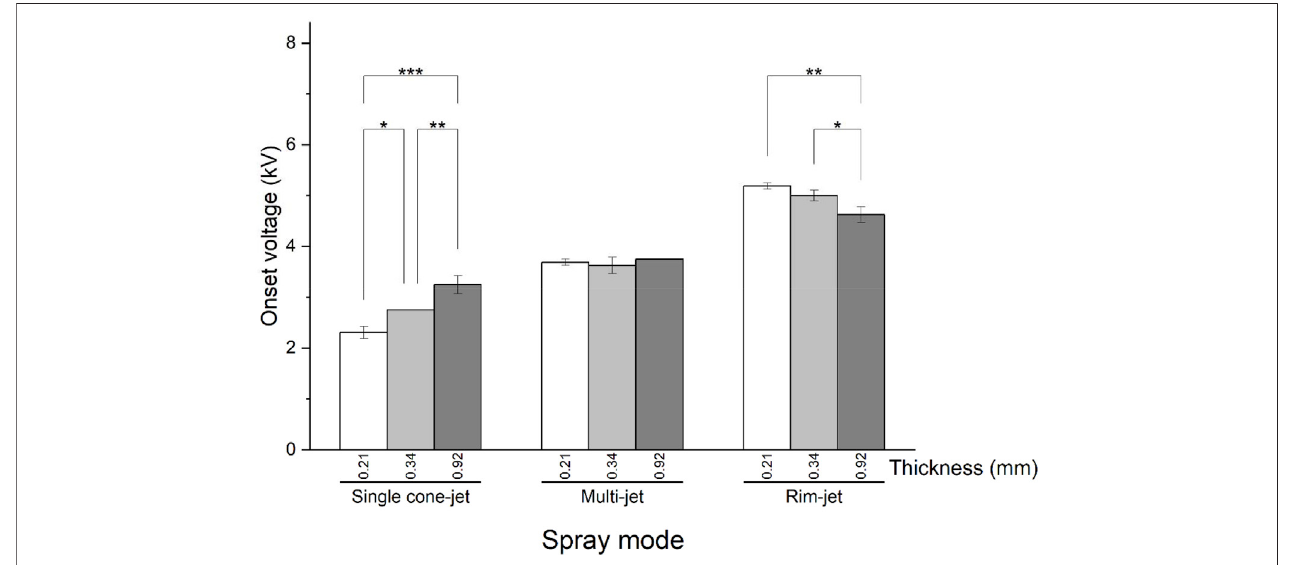
FIGURE4| PSIMSsignalintensityof50 μ g/mltrimethoprimanalyzedat the spray voltage of 5 kV and solvent fl ow rates varying from 20 to 80 μ L/min.